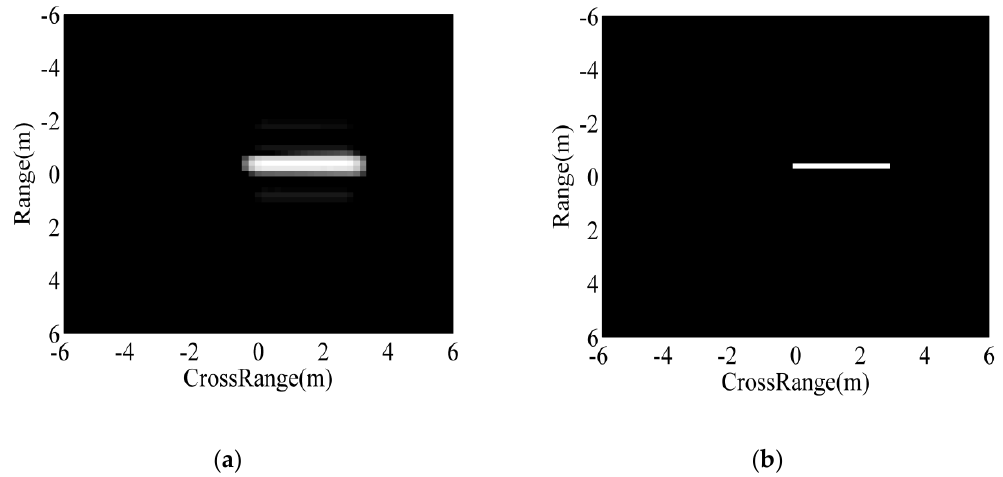
Figure 4. Image and binary region of a distributed ASC: ( a ) image; ( b ) binary region.